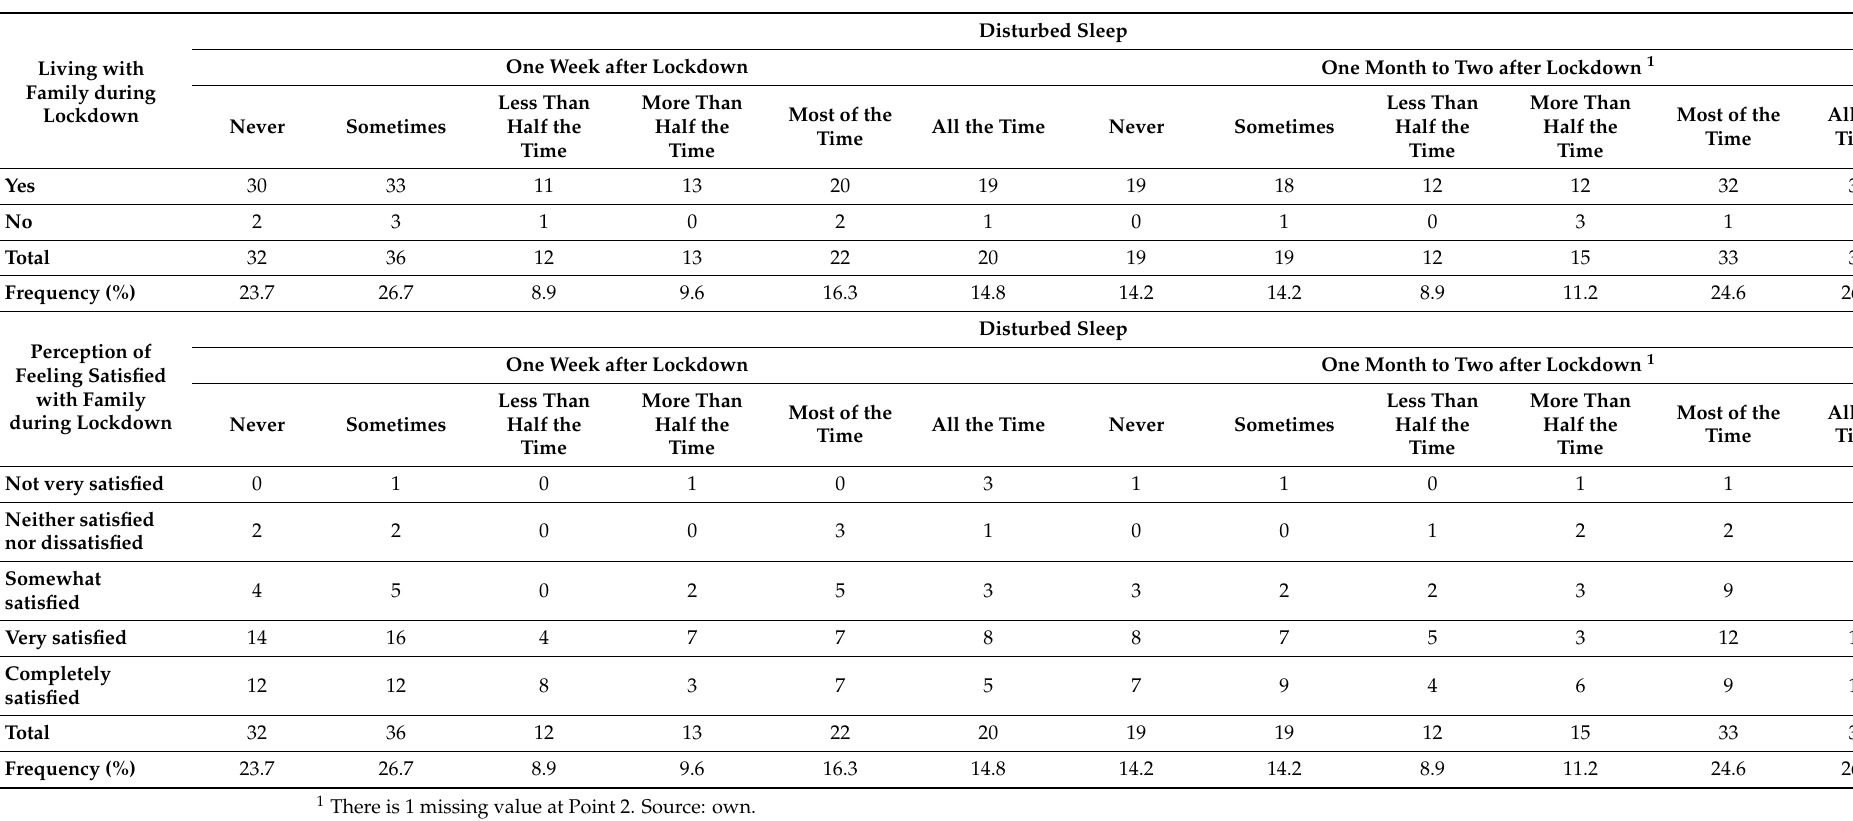
Table 2. Relation between disturbed sleep, living with family, and the degree of satisfaction with family during strict